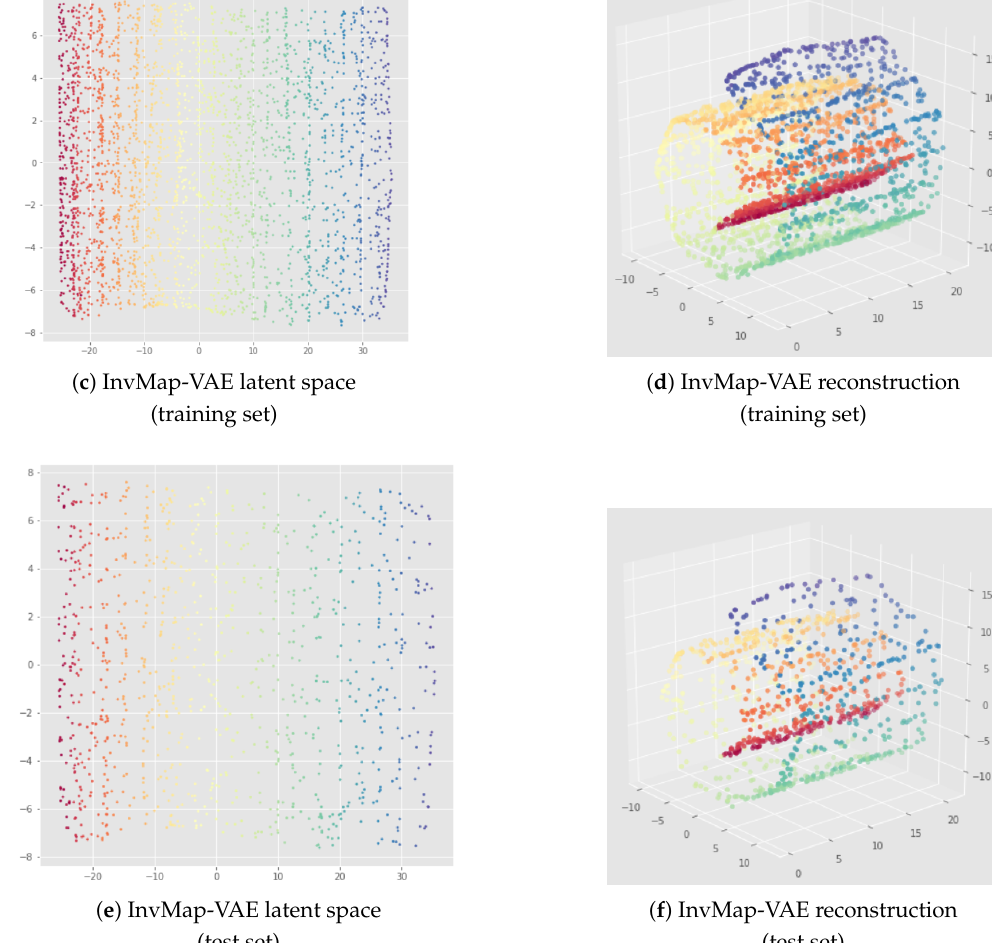
Figure 16. Isomap-based InvMap-VAE applied to the swissroll dataset, weight IM = 1 and trained for 500 epochs. Betti numbers β 0 = 1 and β 1 = 0 are preserved between the original dataset ( a ), the latent representation (( c ) for training and ( e ) for test), and the reconstruction (( d ) for training and ( f ) for test). Moreover, on the contrary to the Isomap embedding ( b ), the latent representations do not have empty regions, which is better for interpolations, although lines appear and are retrieved in the reconstructions. We can notice that the spacing between these lines is actually related to the curvature of the